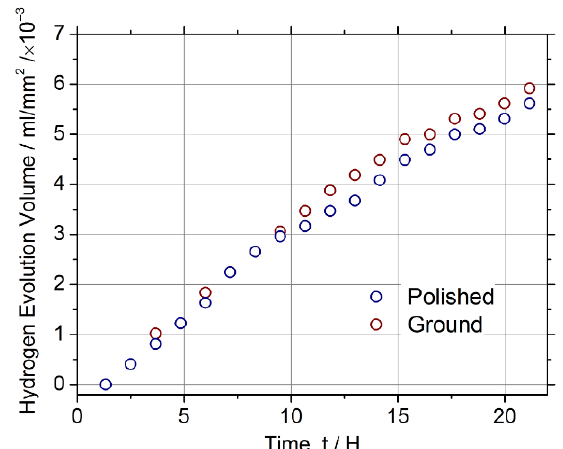
Figure 9. Hydrogen evolution curves for ZK60 specimens, with the ground and polished surfaces tested in Ringers’s SBF at 37 °C.